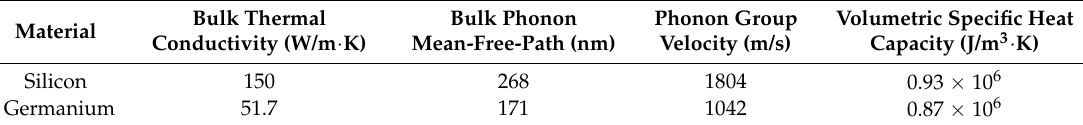
Table 1. Properties used for Ge–Si nanocomposite.